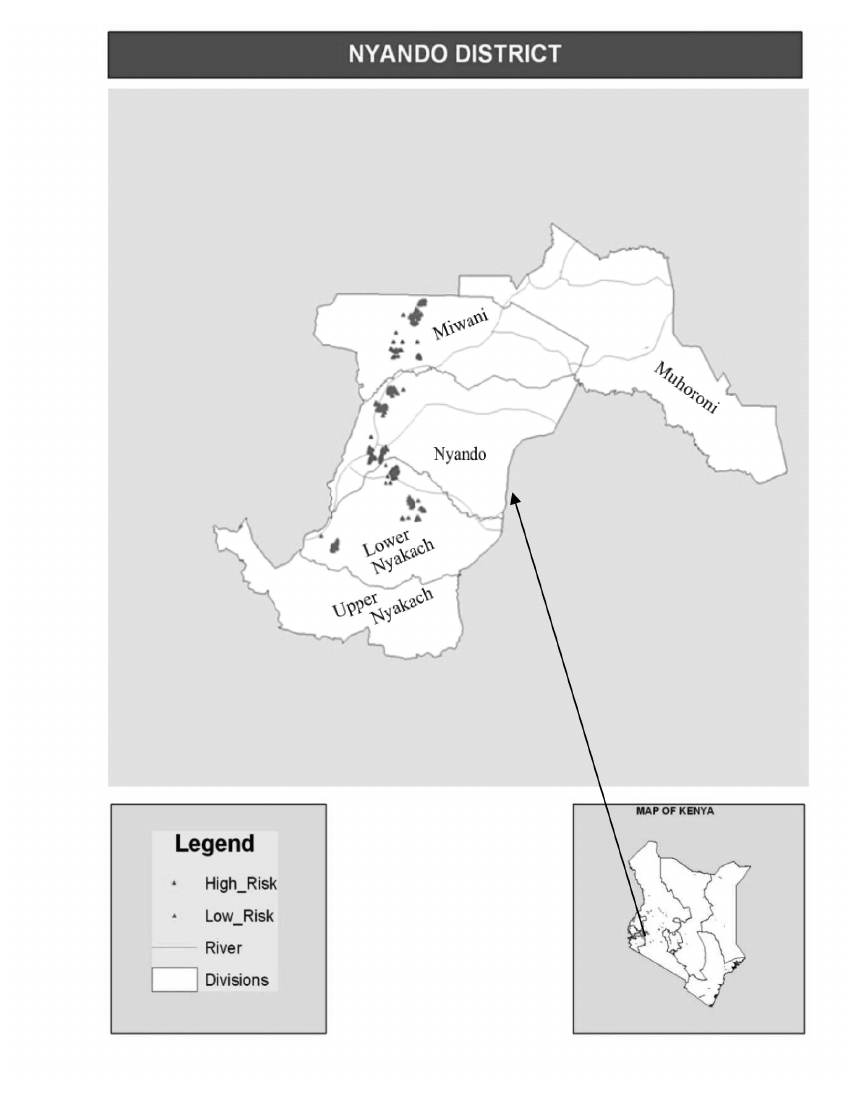
Community perceptions and response to fl ood risks in Nyando District, Western Fig 2. Map showing high and low flood risk areas sampled during the study in Nyando